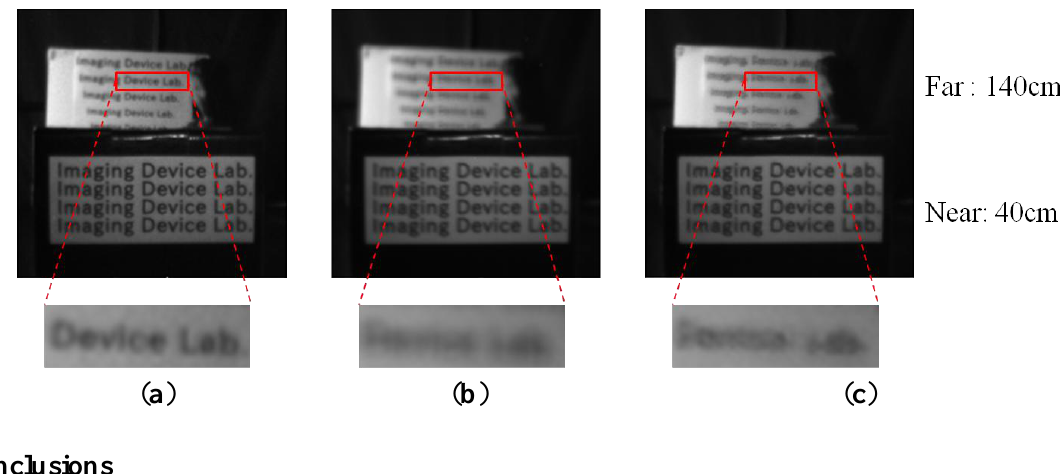
Figure 11. Comparison of. ( a ) Raw and virtually defocused image ( b ) Selective averaging and ( c ) Median